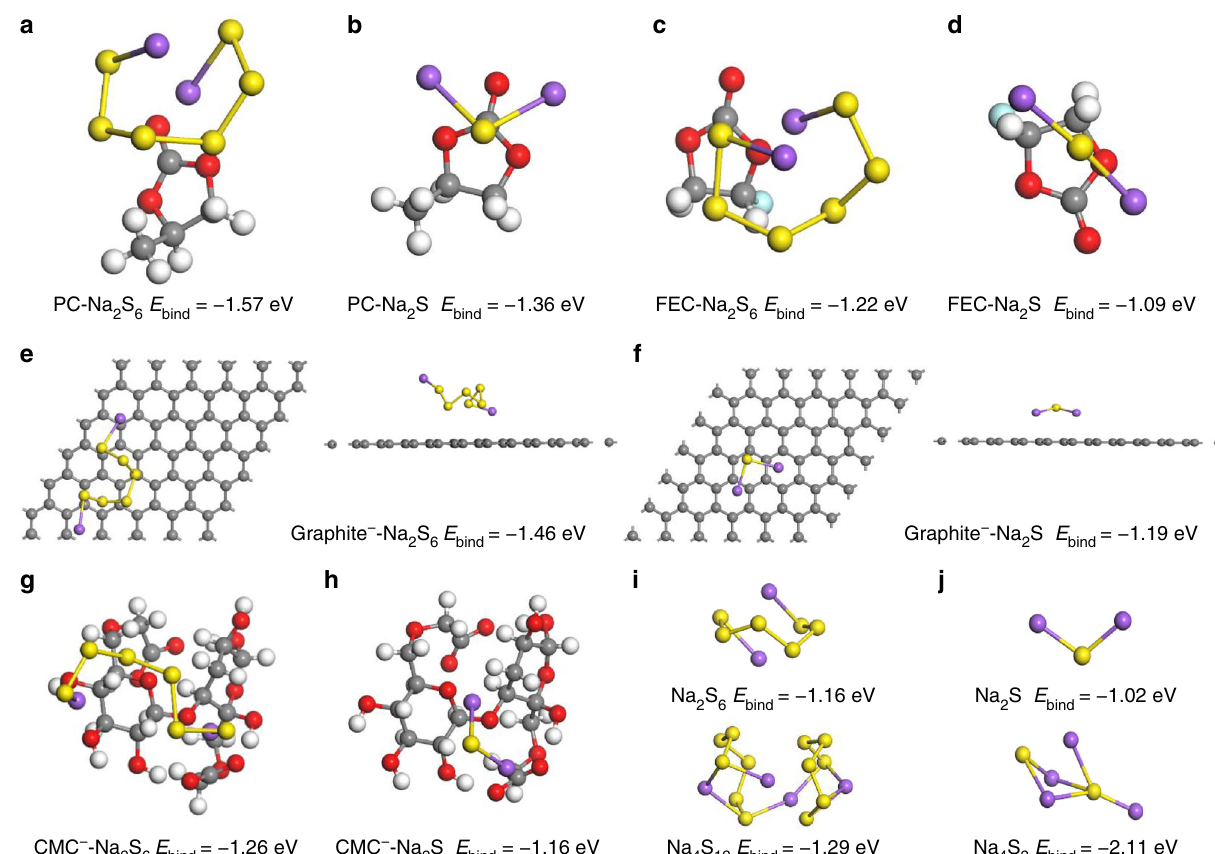
Fig. 5 First-principle simulations. a – d Calculated binding energies of a Na 2 S 6 and b Na 2 S with PC solvent, and c Na 2 S 6 and d Na 2 S with FEC solvent; e , f Binding energies of e Na 2 S 6 and f Na 2 S on graphitized carbon from top view (left) and side view (right); g, h Binding energies of g Na 2 S 6 and h Na 2 S with CMC − ion; i, j Binding energies of the most stable i Na 2 S 6 molecular/Na 4 S 12 cluster, and j Na 2 S molecular/Na 4 S 2 cluster. Yellow, purple, gray, white, red and blue balls represent sulfur, sodium, carbon, hydrogen, oxygen and fl uorine atoms,